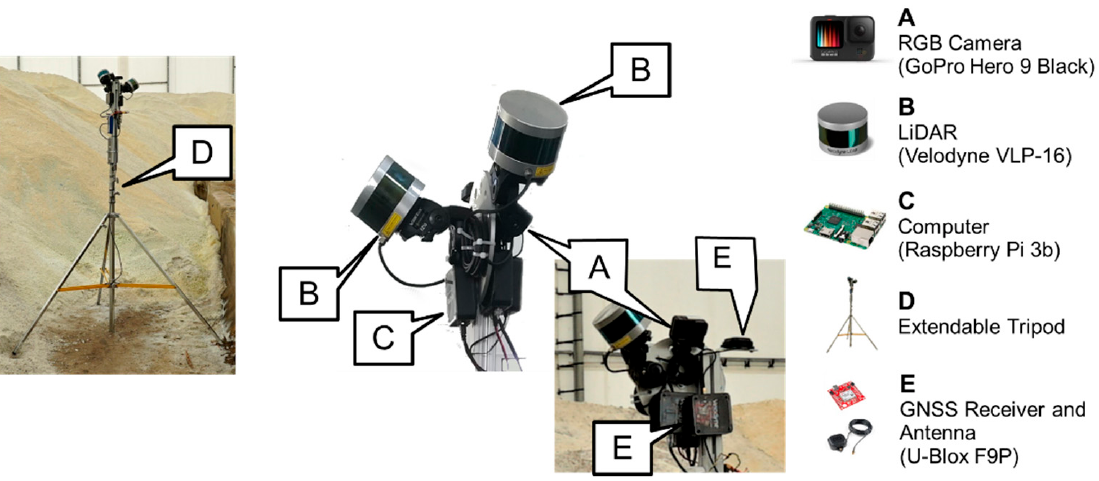
Figure 1. The integrated SMART system with all its major components. System setup for data acquisition within an indoor facility is shown on the left.